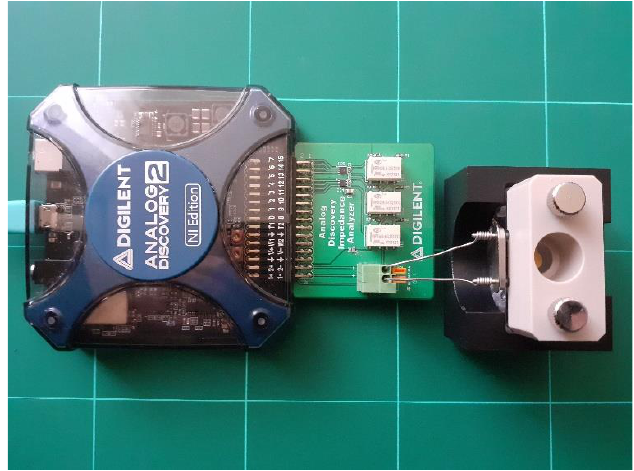
9 of 17 Figure 6. Analog Discovery 2 (AD2) block diagram adapted from its datasheet. The AD2 is a virtual instrument containing two 14 bit 100 MSPS ADC’s and two 14